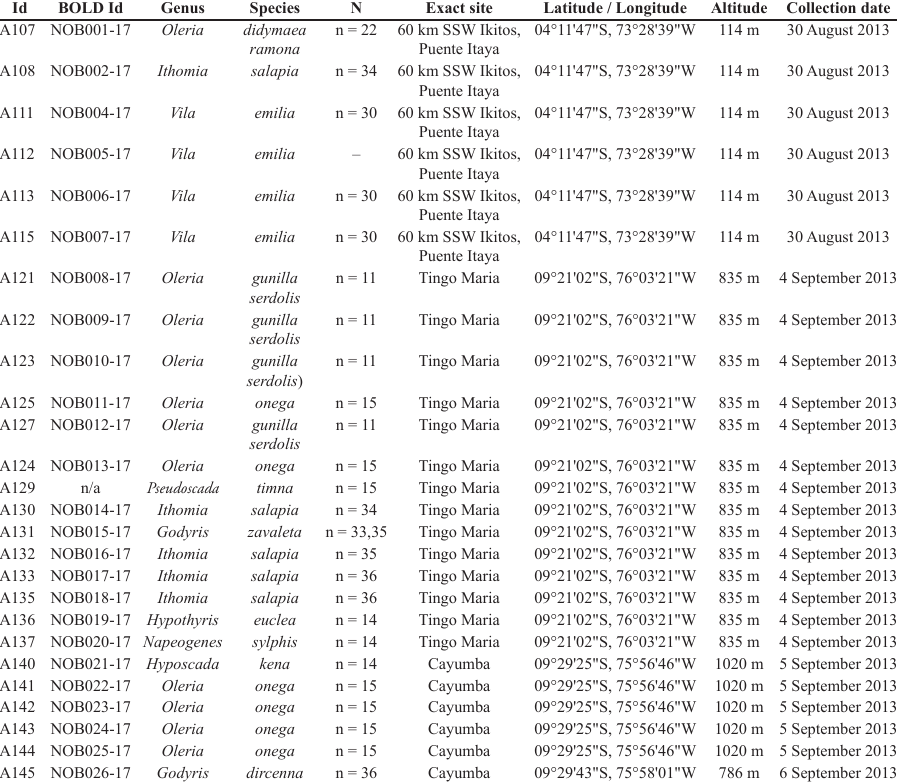
Table 1. List of the samples of the genera Oleria Hübner, 1816, Ithomia Hübner, 1816, Vila Kirby, 1871, Pseudoscada Godman et Salvin, 1879, Godyris Boisduval, 1870, Hypothyris Hübner, 1821, Napeogenes Bates, 1862 and Hyposcada Godman et Salvin, 1879 collected by V.A.Lukhtanov and used in the